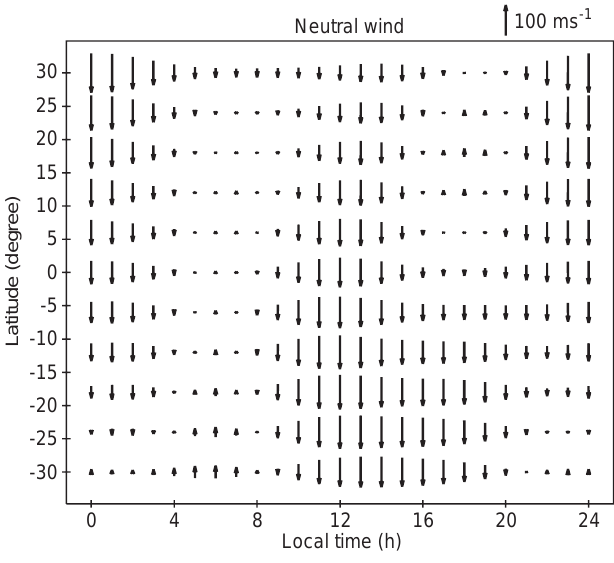
Fig. 5. Diurnal and latitudinal variations of the meridional neutral wind at 600 km altitude given by HWM90 for June